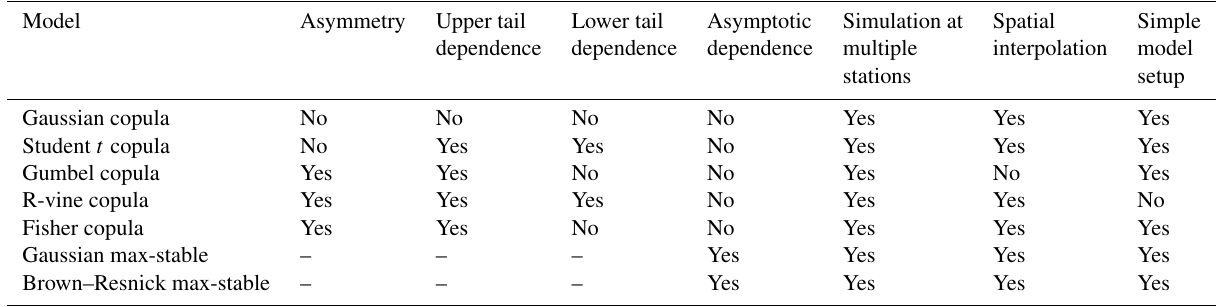
Table 2. Modeling capabilities of copula and max-stable models tested to model spatial dependence. Asymmetry and tail dependence are not specified in the context of max-stable models.